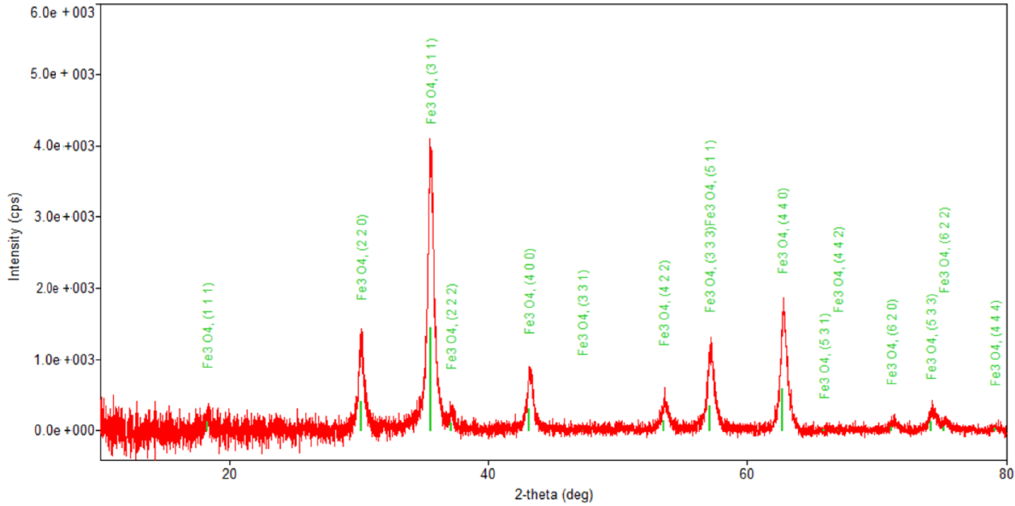
Figure 6. Powder XRD patterns of Fe 3 O 4